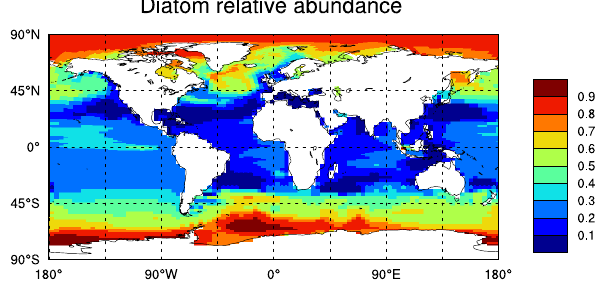
Fig. 2. Diatom relative abundance (no units) defined as the frac- tional contribution of diatom biomass to phytoplankton biomass, averaged for years